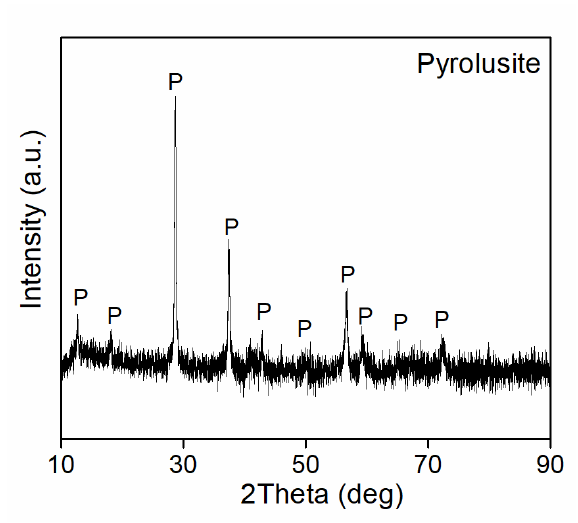
Figure A3. XRD result for manganese PA. Pyrolusite (P) was identified.